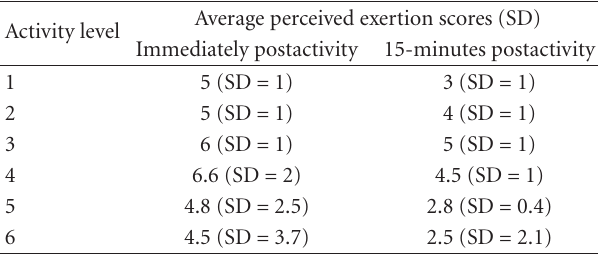
Table 3: Average perceived exertion